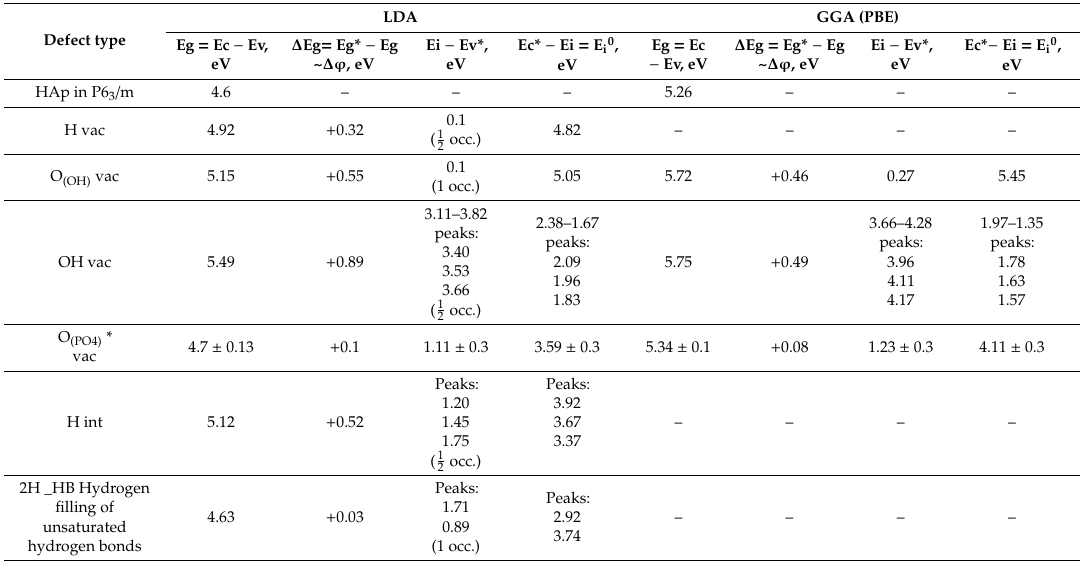
Table 3. Calculated data for HAp defects by two various approaches (average errors = ± 0.05 eV). Defect